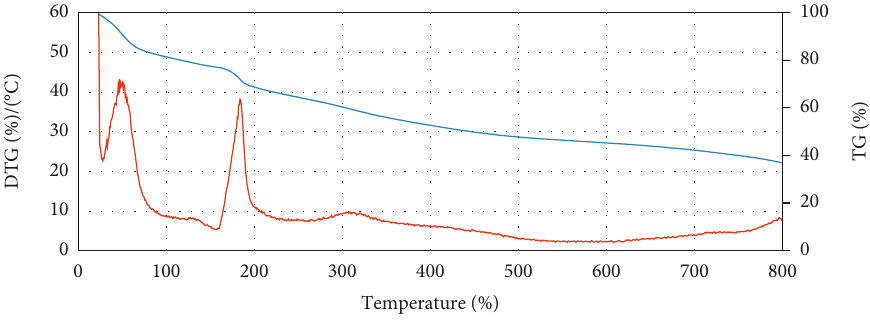
Figure 7: TGA curve and DTG curve for Caulerpa lentillifera .